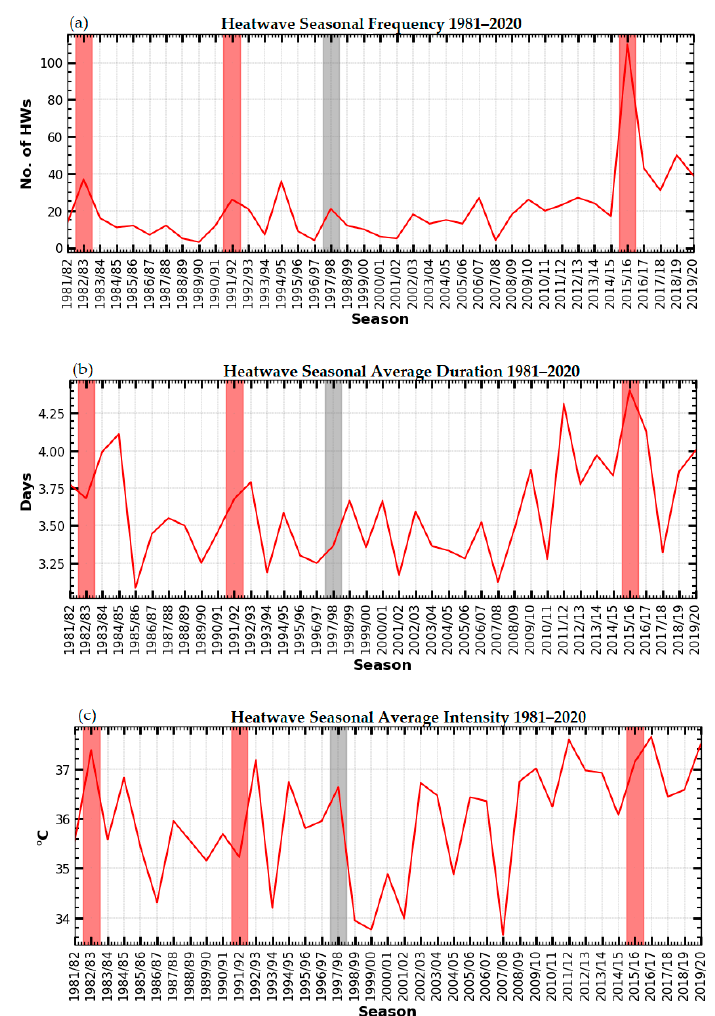
Figure 7. Seasonal variability of ( a ) HW frequency (red line), ( b ) average duration (red line, days), and ( c ) average intensity (red line, ◦ C) over South Africa from 1981 to 2020 from all 24 selected stations. The shades of red and gray represent intense El Niño seasons of 1982/83 (red), 1991/92 (red), 1997/98 (gray) and 2015/16 (red).